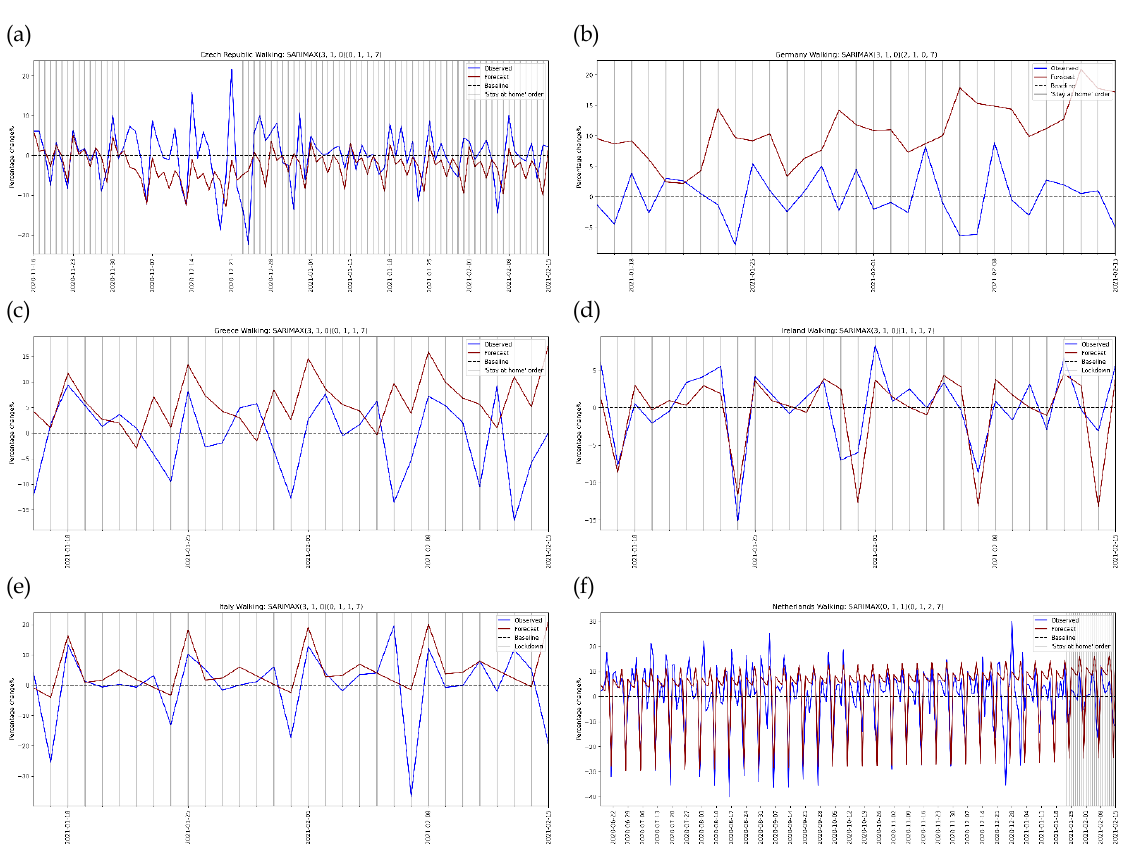
Figure 10. SARIMAX forecasts for walking in relation to “Stay at home” orders (a: Czech Republic, b: Germany, c: Greece, d: Ireland, e: Italy, f: Netherlands